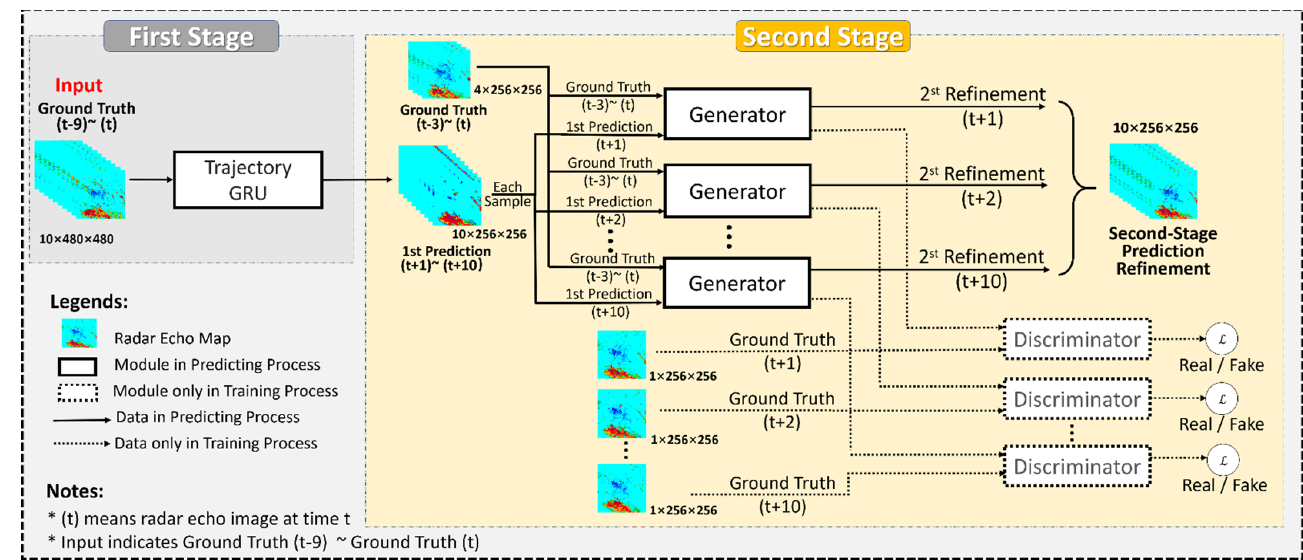
Figure 2. The structural framework and process details of the proposed model, consisting of a pre-prediction stage, the first stage on the left with gray background, and a refinement stage, the second stage with the yellow background on the right. Detailed structure parameters can be found in Tables 1 and 2.